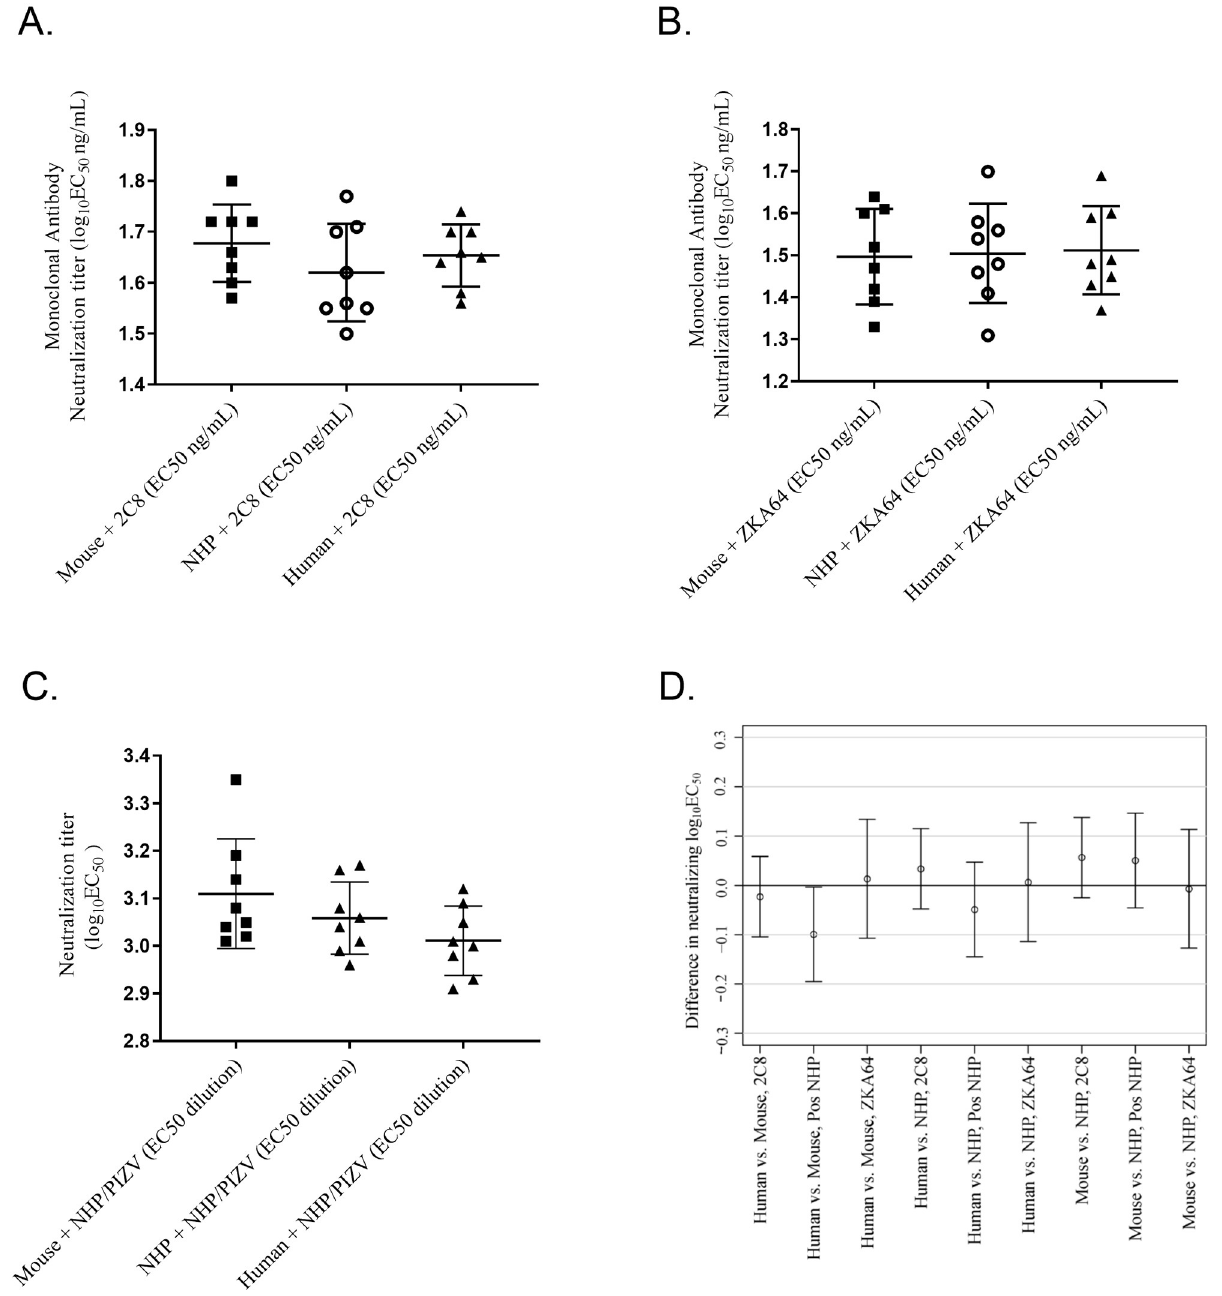
Fig 9. The Z-RVP-384 assay consistently measure neutralizing titers in human, rhesus macaque and CD-1 mouse sera. ZIKV neutralizing titers in human, rhesus macaques (NHP) and mouse sera was measured after addition of (A) mAb 2C8; (B) mAb ZKA64; (C) ZIKV neutralizing rhesus macaque polyclonal serum. (D) differences in mean log 10 EC 50 titers plus 95% CI between the different sera, by spiking group. For mAbs EC 50 are expressed as ng/mL, and for sera EC 50 are expressed as reciprocal serum dilution.